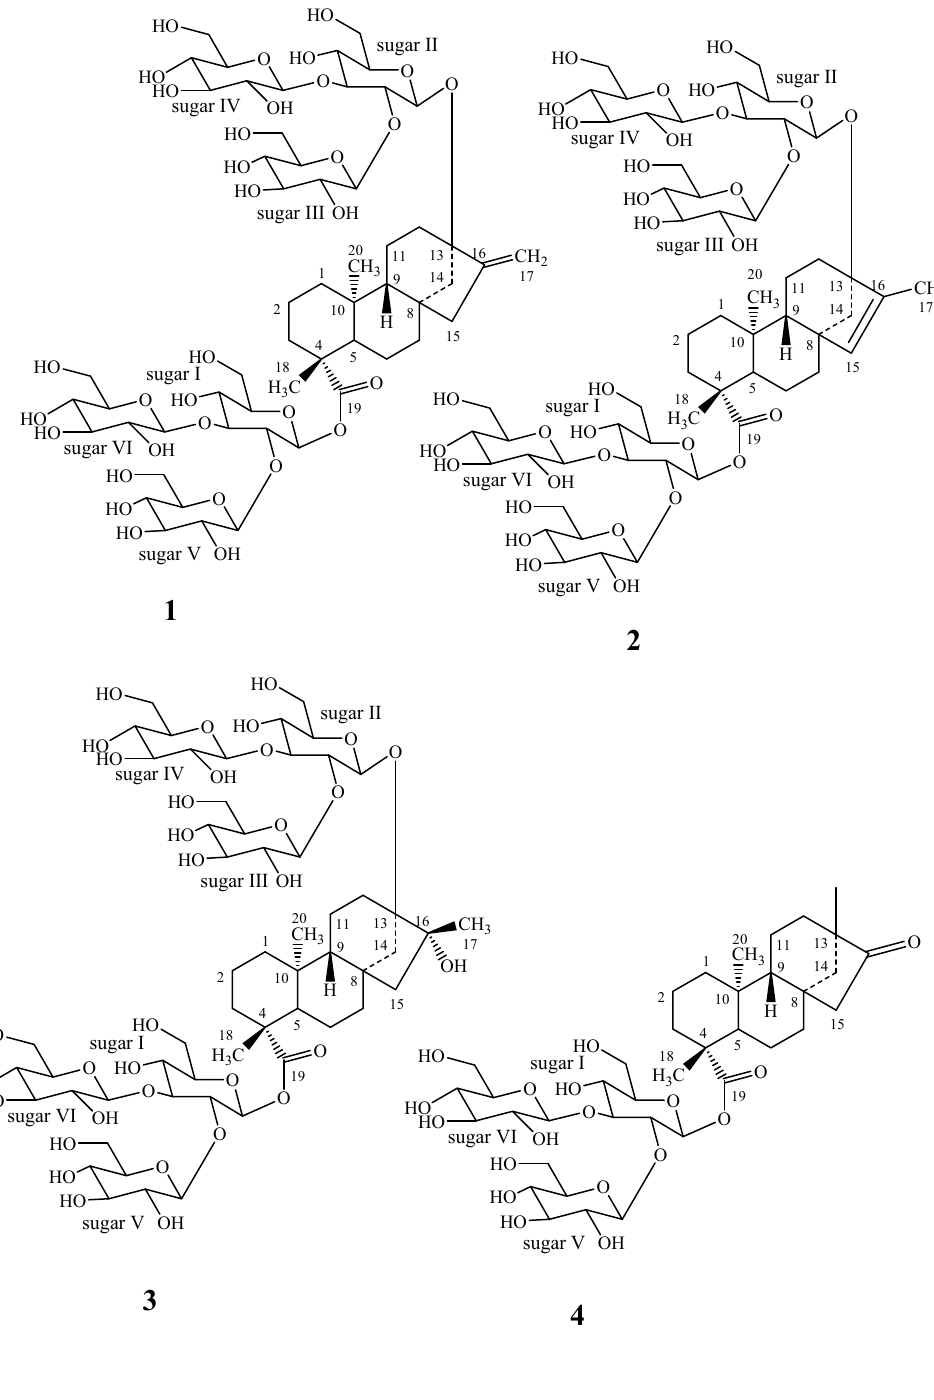
Figure 1. Structures of rebaudioside M ( 1 ) and its degradation compounds 2 – 4